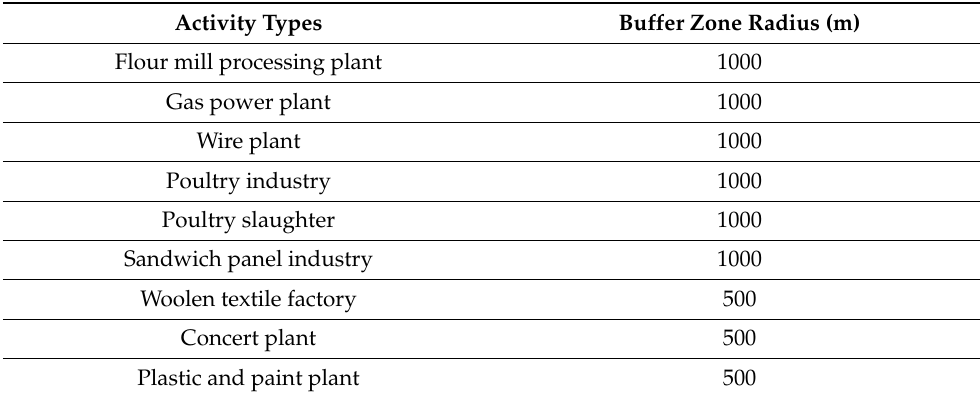
Table 2. Examples of moderately polluting projects (Class B) according to Iraqi environment standards.